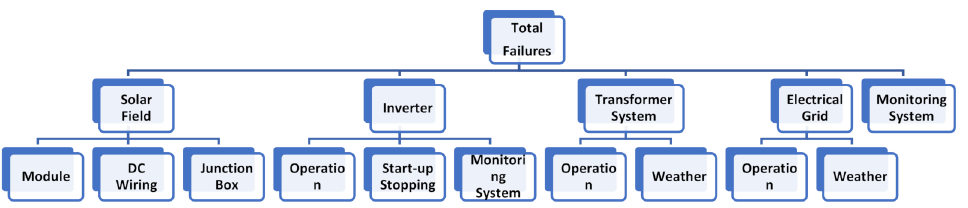
Figure 3. Classification of failures according to the equipment in PV systems.